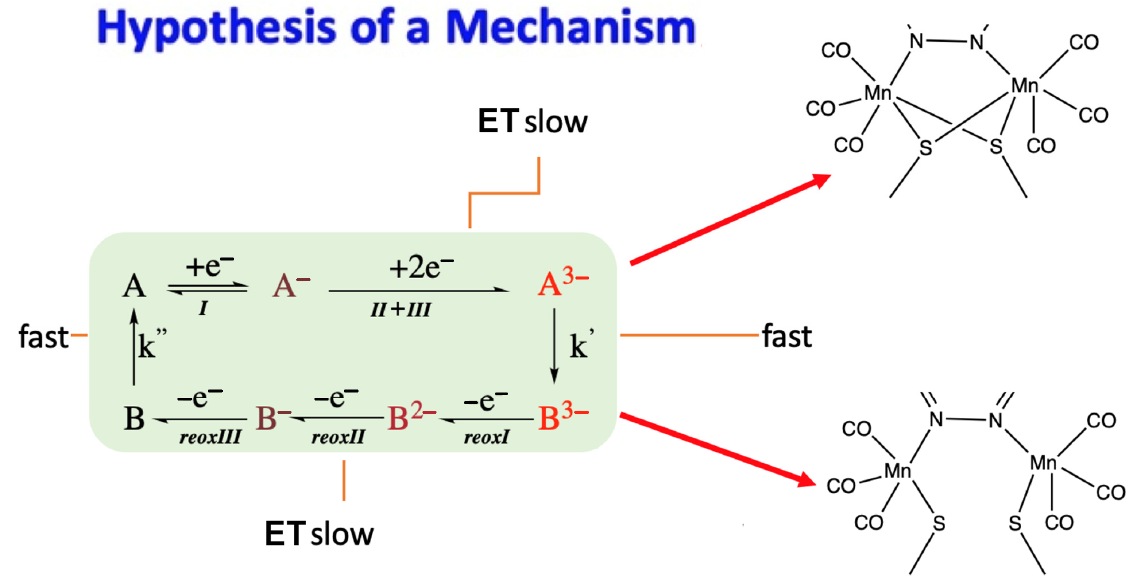
mental data of Mn-SMe . Simulations parameters fitted using experimental CVs with scan rate 0.4 V/s ( a ) and 10.0 V/s ( b ). Ar atmosphere, TBAH/DMF electrolyte solution, working electrode: GC; reference electrode: SCE; T= 298 K .